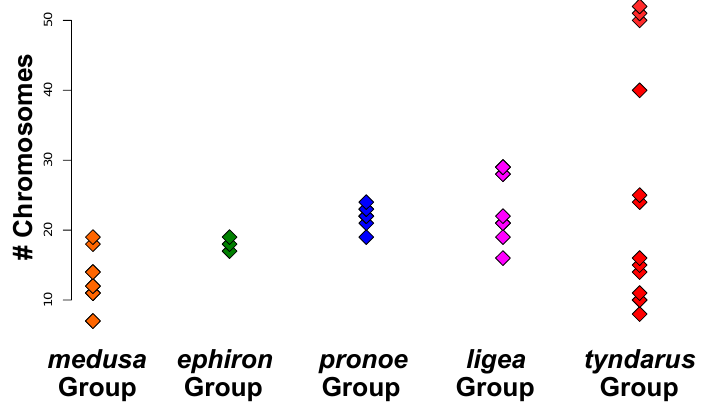
Figure 1. Dot plot summarizing the variation in haploid chromosome numbers among the five European Erebia groups according to [26]. Data is from [22]. Erebia medusa group (orange), E. ephiron group (green), E. pronoe group (blue), E. ligea group (pink), E. tyndarus group (red).